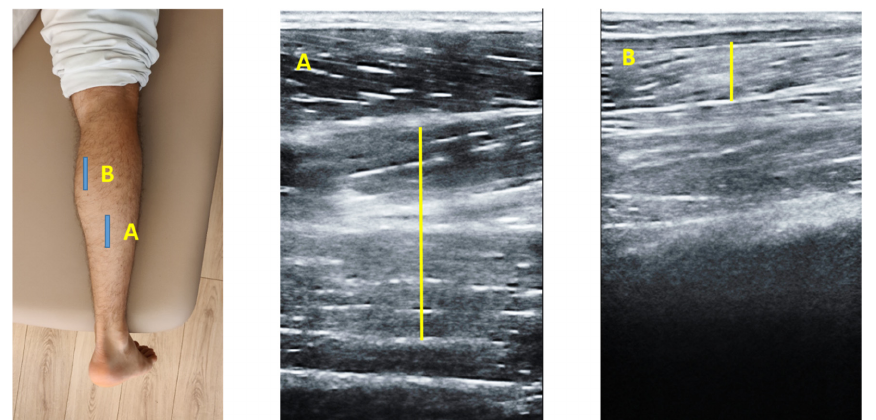
Figure 1. Ultrasound imaging thickness and CSA of the TP muscle. ( A ) Upper third of the imaginary line in a longitudinal view (thickness) and ( B ) Transversal view (CSA) to identify the TP.